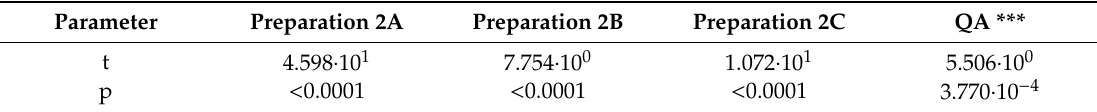
Table 4. Parameters of the Student’s t